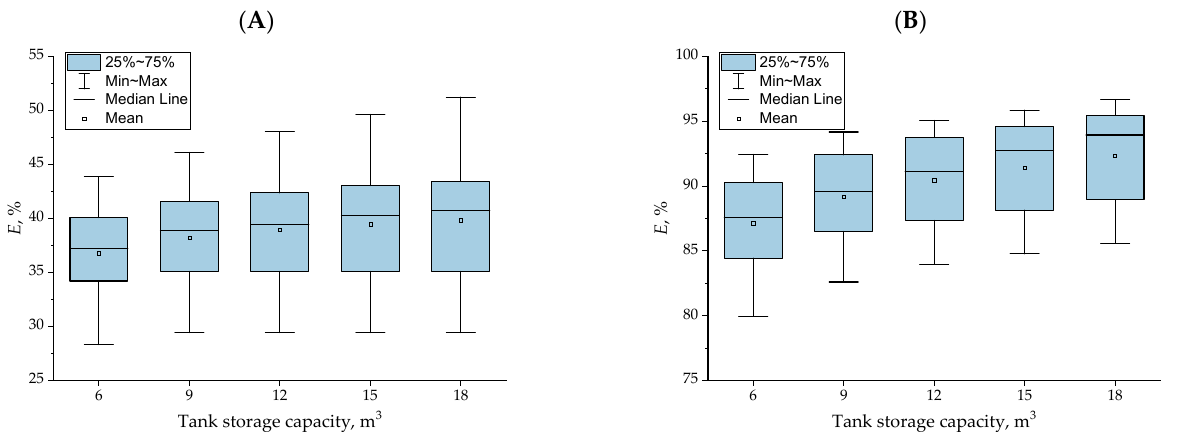
Figure 4. Comparison of the water-saving efficiency with different tank storage capacity for the rainwater harvesting (RWH) system ( A ), and the RWH system cooperating with water recovery from the exhaust air ( B ).